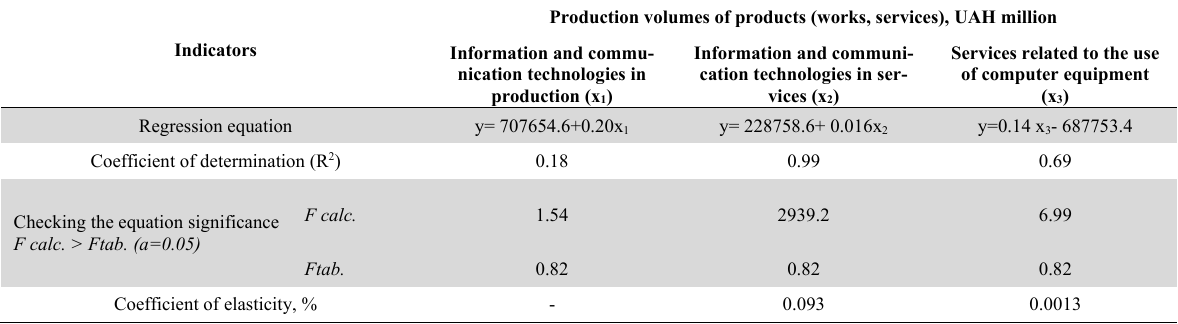
Production volumes of products (works, services), UAH million Information and commu- Information and communi- Services related to the use nication technologies in cation technologies in ser- of computer equipment production ( х 1 ) vices ( х 2 ) ( х 3 )